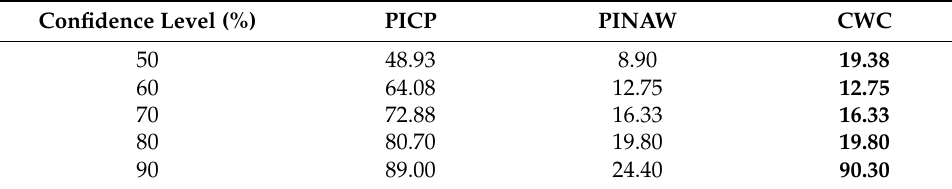
Table 4. Three-hour-ahead PIs using RWRF and WEPS (Method 1a).